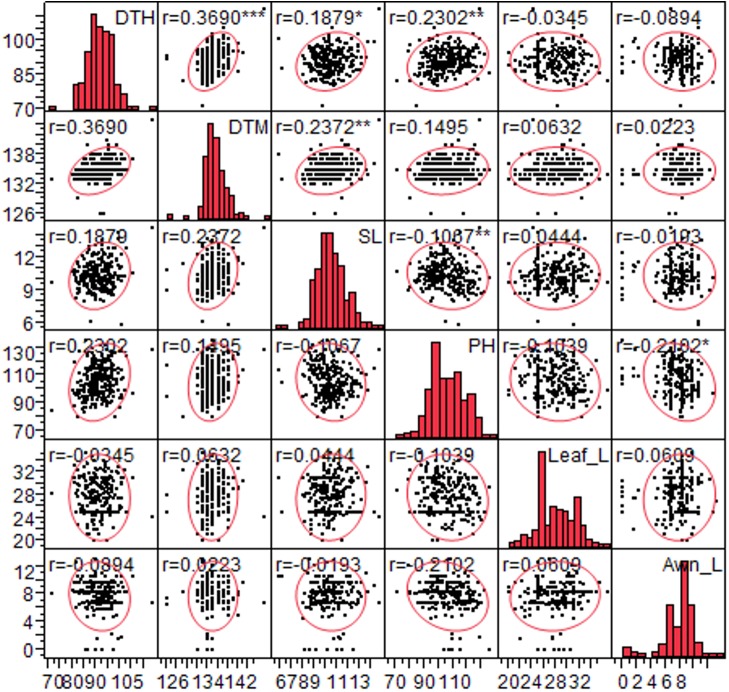
Correlation between six quantitative traits viz. Days to heading (DTH), days to maturity (DTM), spike length (SL), plant height (PH), leaf length (Leaf_L) and Awn length (Awn_L) for 260 genotypes. Significant correlations are designated with asterisk (∗).